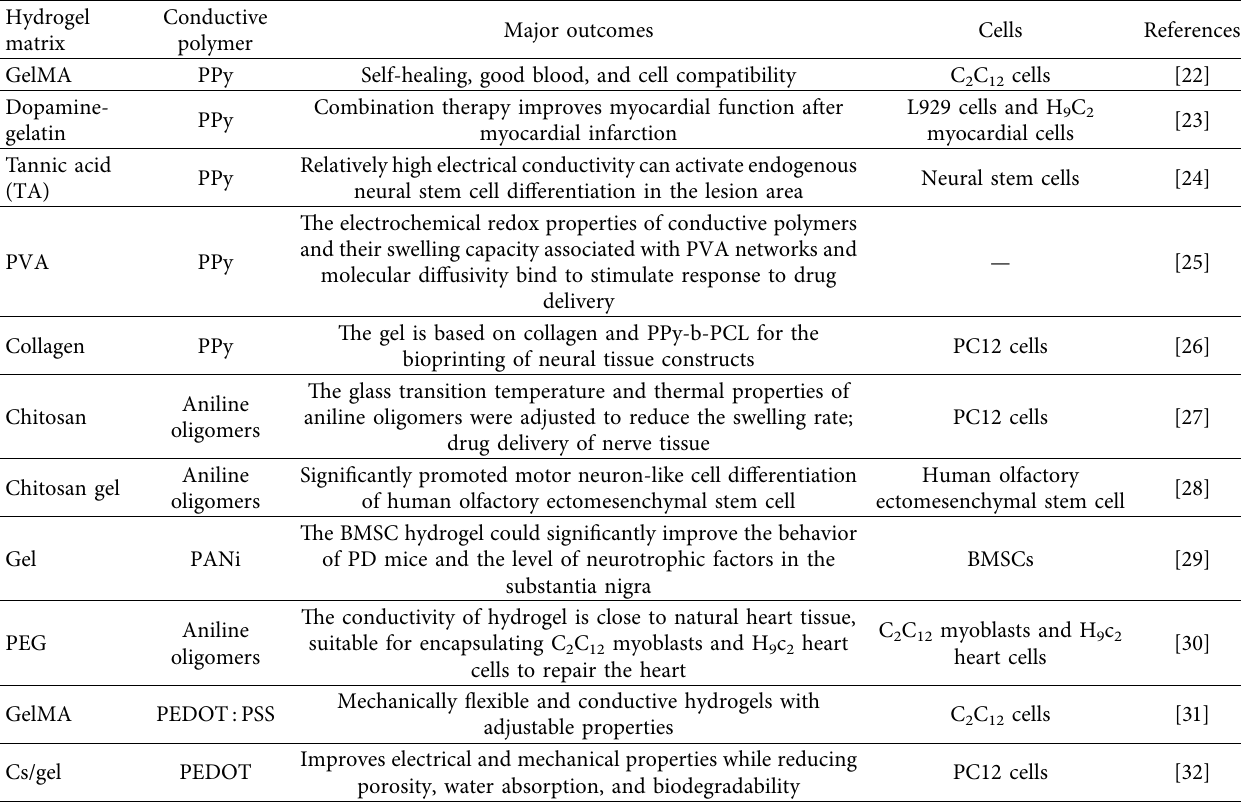
Table 1: Some application of conductive polymer hydrogels in